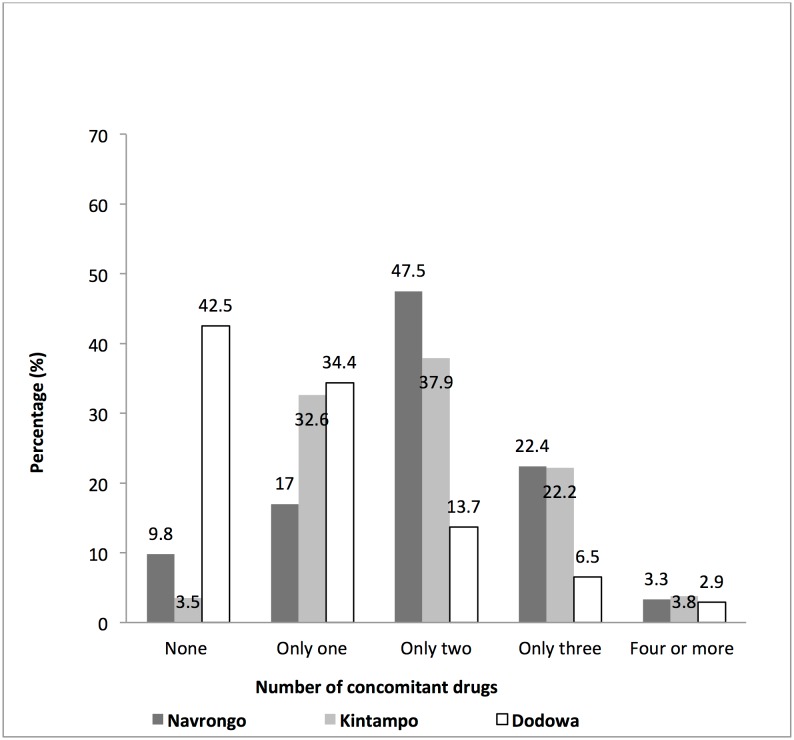
The total number of concomitant medication per study site taken by study participants during the study period.